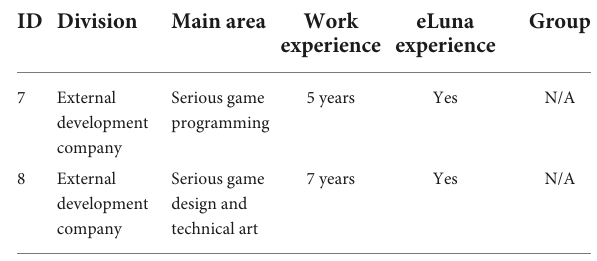
TABLE 2 Serious game developer respondents.